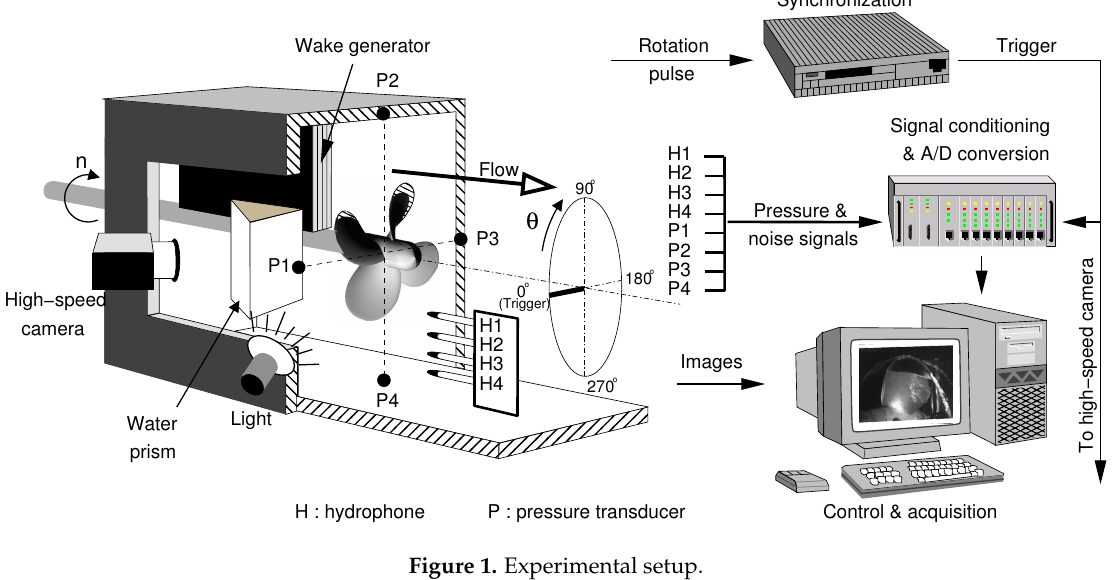
Figure 1. Experimental